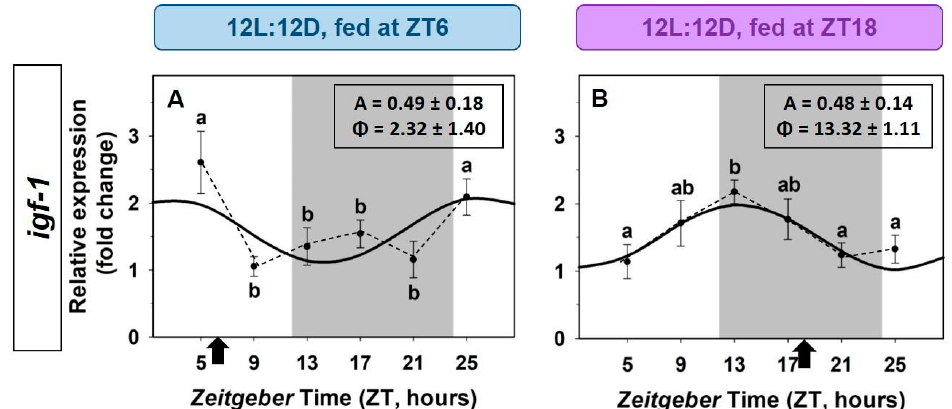
Figure 5. Effect of a shifted mealtime on the daily expression of igf-1 in the liver of goldfish. ( A ) ML